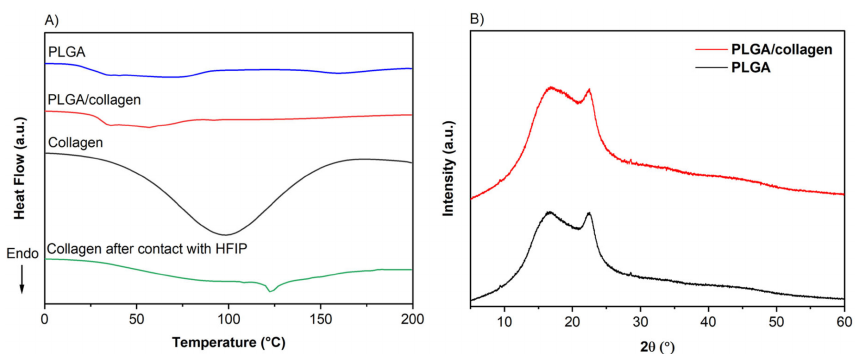
Figure 7. ( A ) Differential scanning calorimetry (DSC), and ( B ) XRD pattern of PLGA and PLGA/collagen. Thermograms of lyophilized and prepared by solvent casting in HFIP collagen were also shown for